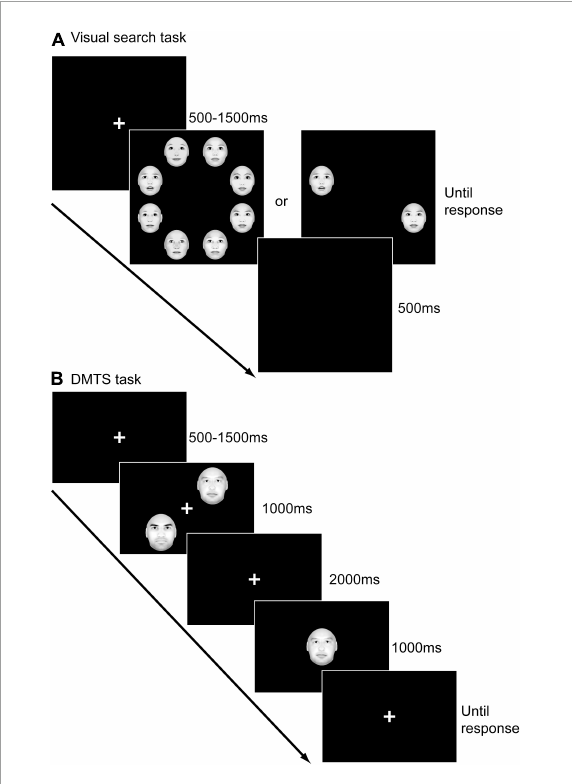
FIGURE1 The experimental procedures of the visual search task (A) and the delayed-match-to-sample (DMTS) task (B)